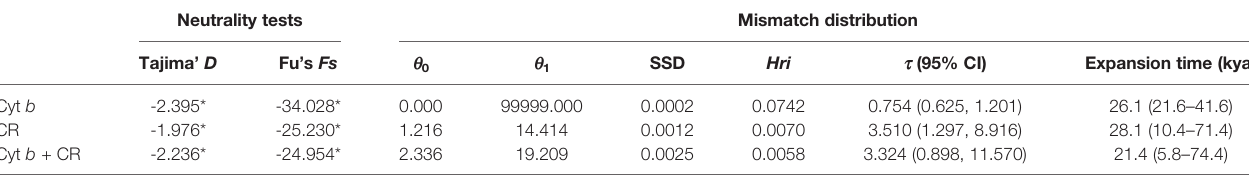
TABLE 4 | Neutrality tests and mismatch distribution analysis for D. maruadsi population. Neutrality